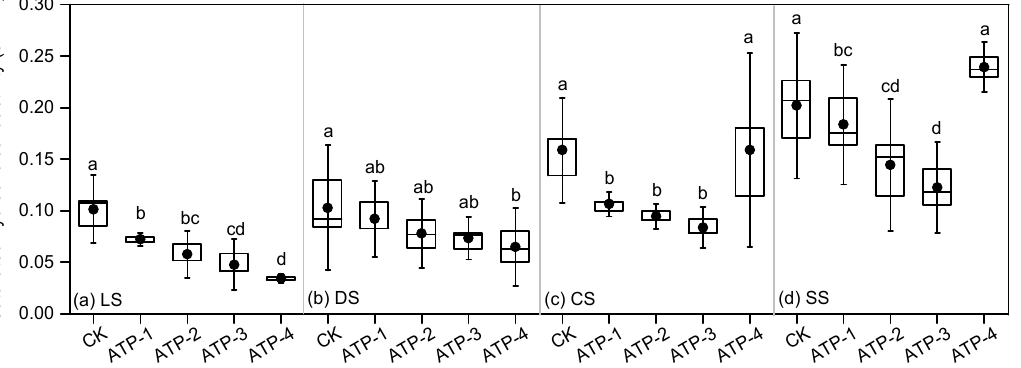
Figure 4. Saturated hydraulic conductivity (K s ) for lou soil (LS), dark loessial soil (DS), cultivated loess soil (CS), and sandy soil (SS). Different lowercase letters indicate significant differences in the parameters for different ATP amounts applied in the same soil type. Error bars refer to the standard deviation.